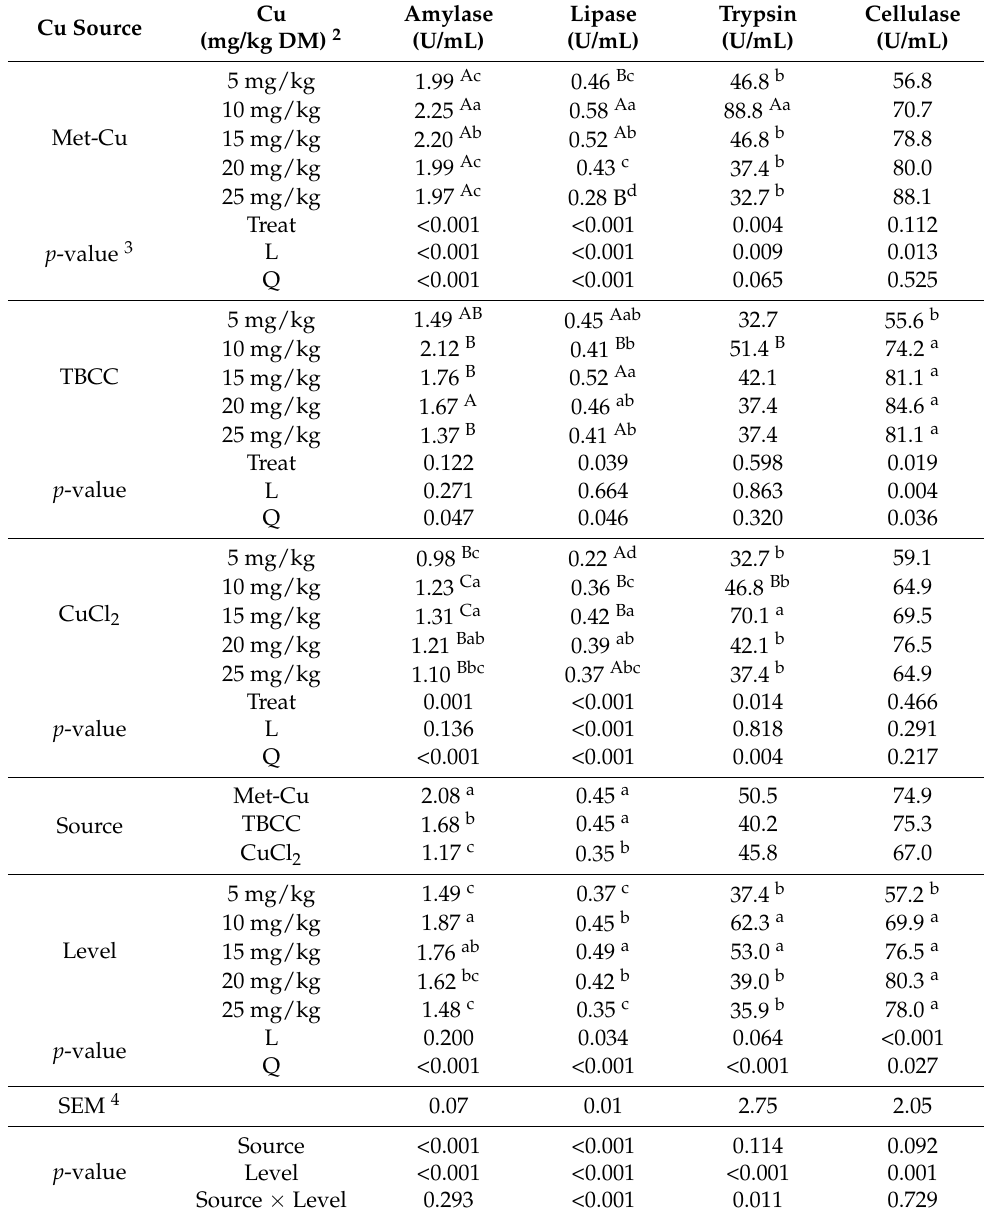
Table 4. In vitro digestive enzyme activities from substrate with added copper (Cu) from different sources at different levels 1